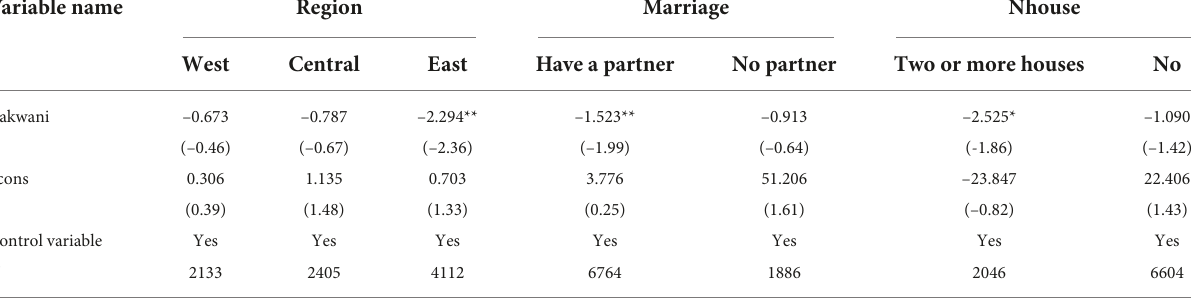
TABLE 5 Heterogeneity analysis